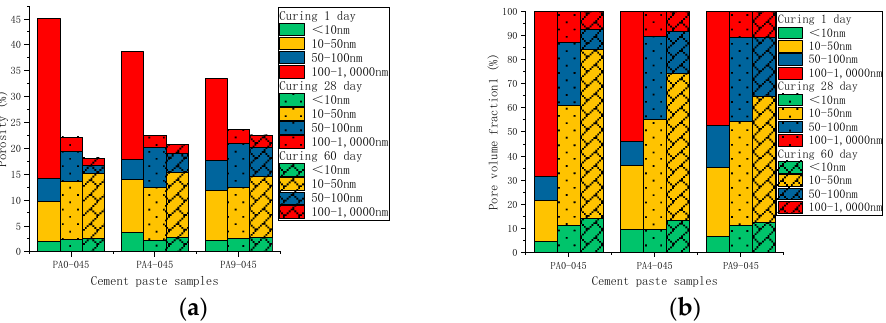
Figure 13. The pore size distribution of hydrated cement pastes with different dosages of the AS Figure 14. The pore distribution of hydrated cement pastes with different dosages of the AS accel- accelerator: ( a ) PA0-045; ( b ) PA4-045; ( c ) PA9-045. erator: ( a ) the porosity; ( b ) the pore volume fraction.